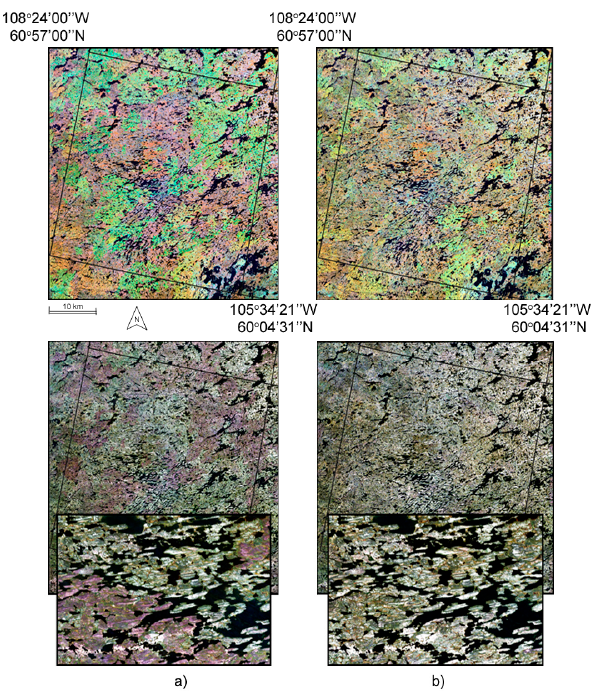
Figure 2. Landsat mosaics of National Topographic System map 75B: The image ( a ) shows the long-term average. The image ( b ) shows the long-term average with fire scars removed. The top image is RGB composite with near infrared band in red, shortwave infrared band in green and blue band in red. The bottom mosaics and the zoomed-in examples are true colour images composite as red band in red, green band in green, and blue band in blue.